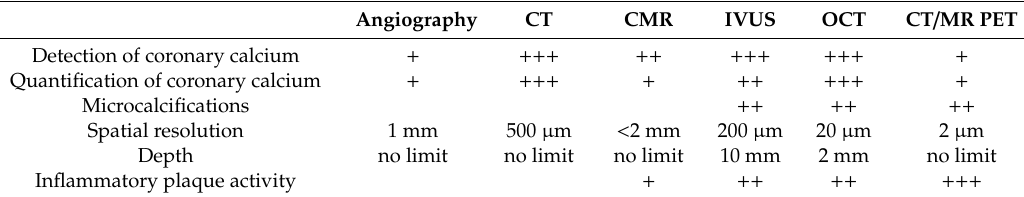
Table 1. Properties of invasive and non-invasive imaging modalities. Cardiac magnetic resonance (CMR); positron emission tomography (PET).